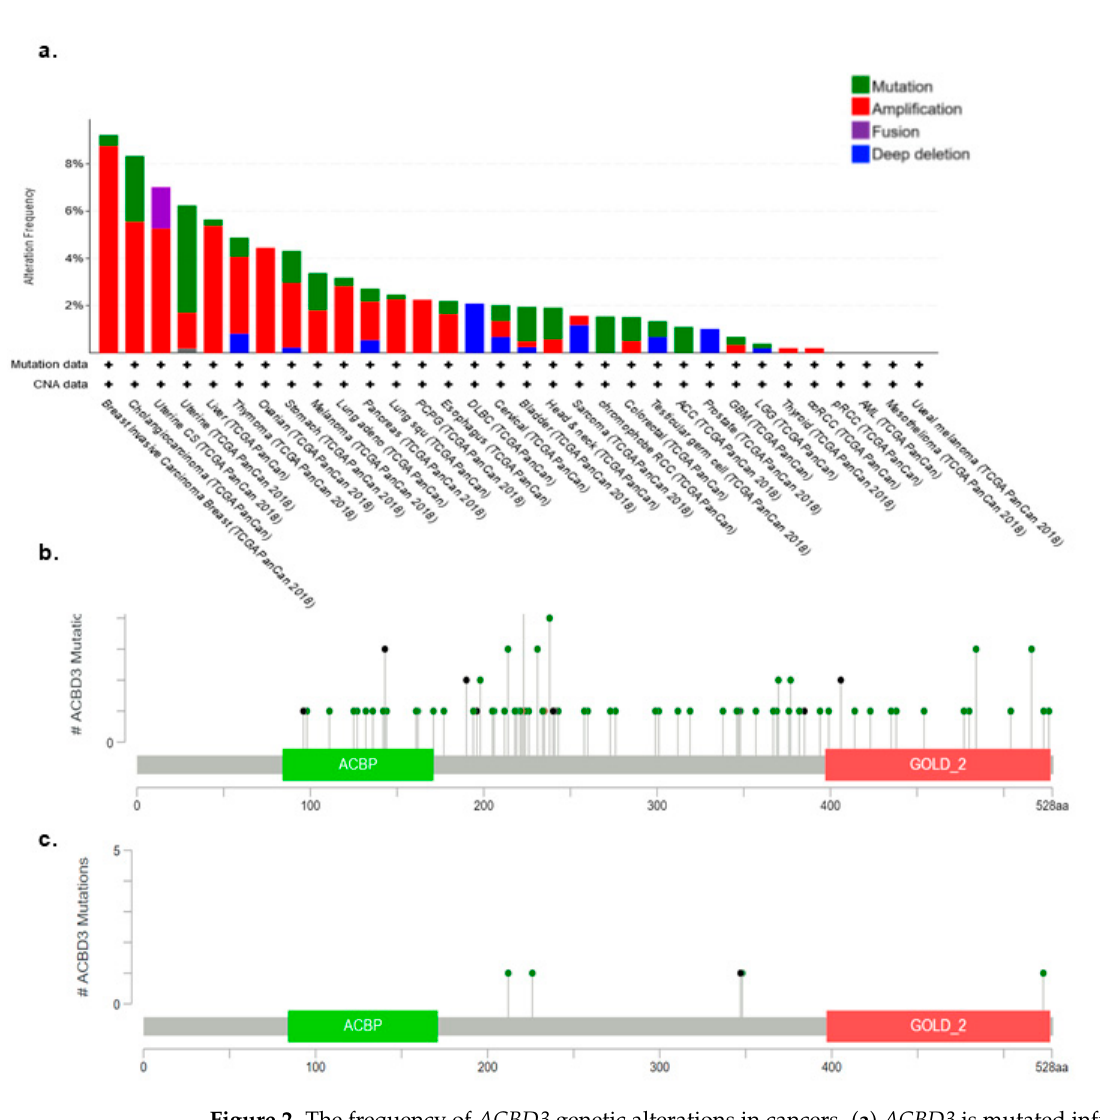
Figure 2. The frequency of ACBD3 genetic alterations in cancers. ( a ) ACBD3 is mutated infrequently in breast cancers but is amplified more in breast cancer than in any other cancer. ACBD3 is most frequently mutated in adrenocortical carcinoma. ( b ) Position and frequency of mutations in ACBD3 that result in amino acid changes for all cancers and ( c ) breast cancers. The ACBP and GOLD domain are highlighted; ACBD3 somatic mutation frequency in breast cancers was 0.5%.